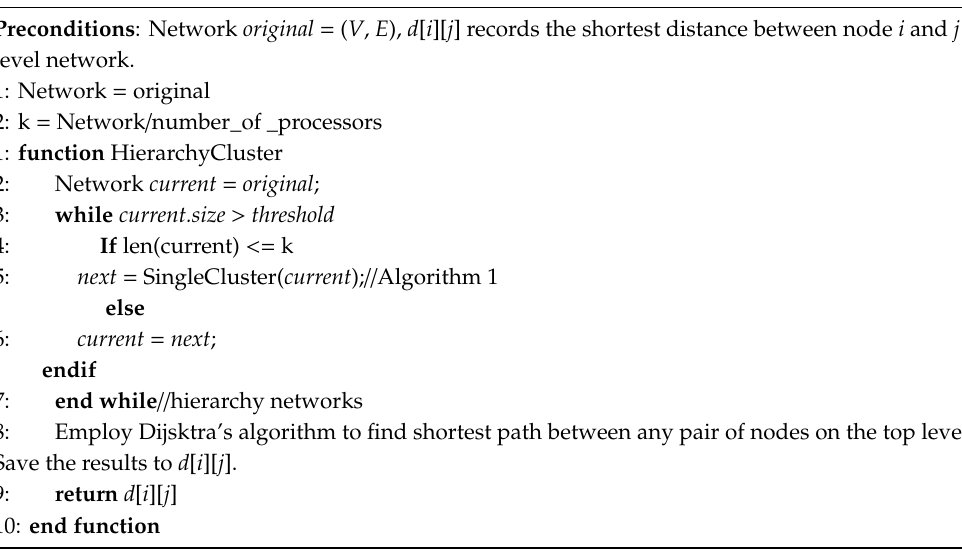
Algorithm 2. Hierarchy Networks